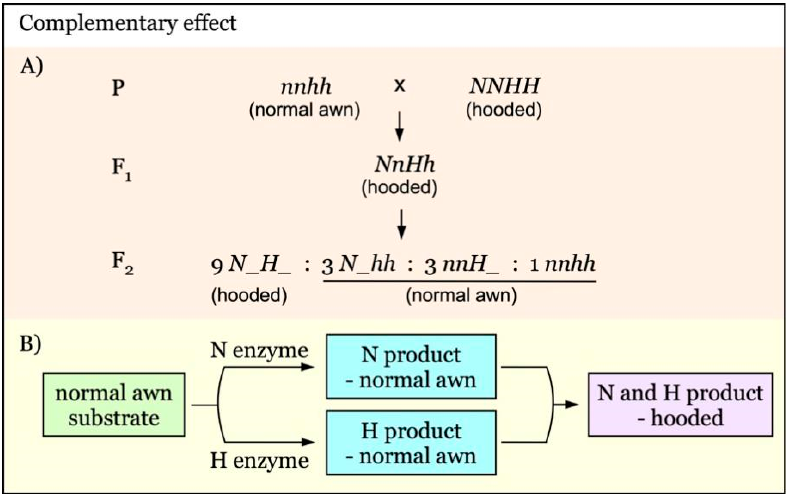
Figure 3. Model of interaction of awnness genes with a complementary effect. ( A ). N and H are independent genes with a complementary effect. ( B ). In the presence of either N enzyme or H enzyme, only normal awns are produced. In the coexistence of H enzyme and N enzymes, the normal awn intermediate would be further converted to the hooded product (Hooded phenotype).